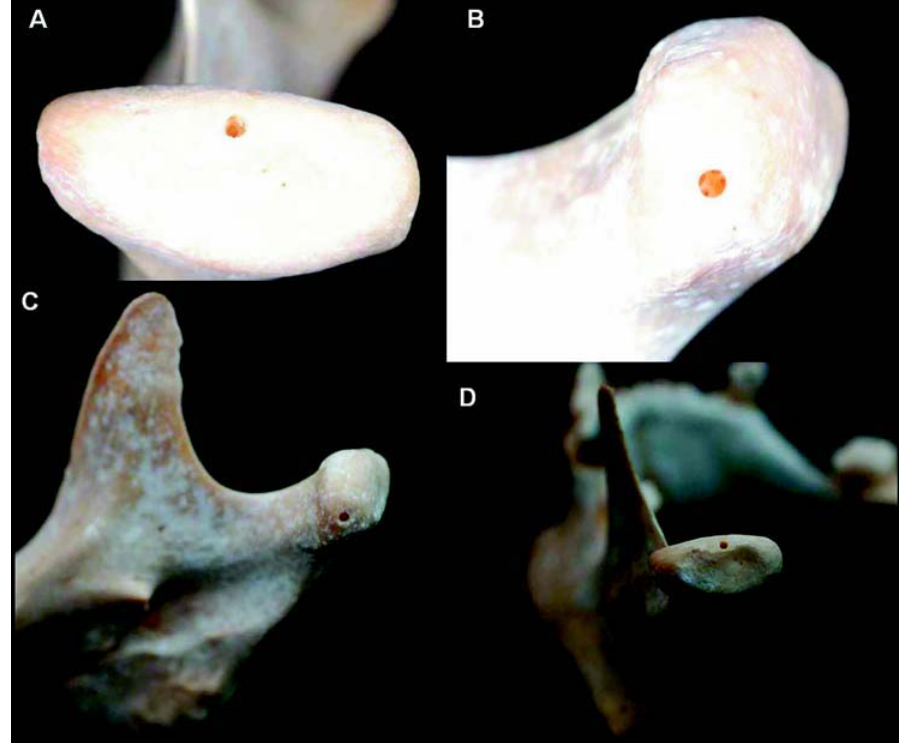
FIGURE 2- Views of the simulated lesions in different regions of the head of the mandible, (A) superior, (B and C) medial, (D)